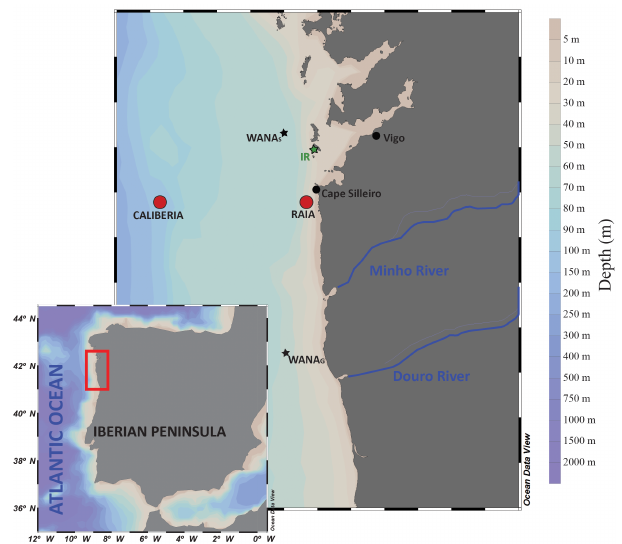
Figure 1. Map of the NW Iberian Margin showing CALIBERIA and RAIA stations. Location of Cíes meteorological station (IR, in green), and WANA hindcast reanalysis points WANA S and WANA G (black stars) from which irradiance and wave data were respectively obtained (Zúñiga et al.,